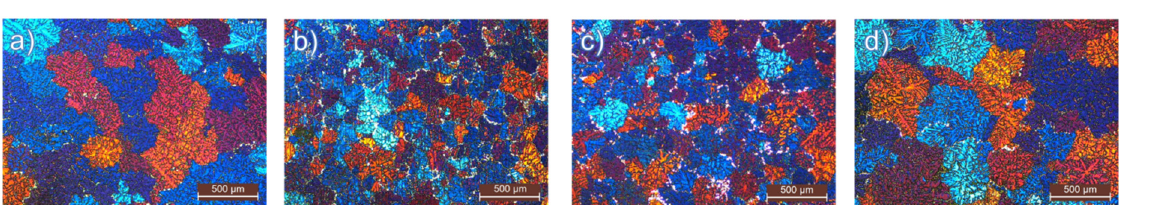
Figure 2. Influence of superheating on the grain size for ( a ) CP AZ91 (AGS: 332 μ m), ( b ) CP AZ91